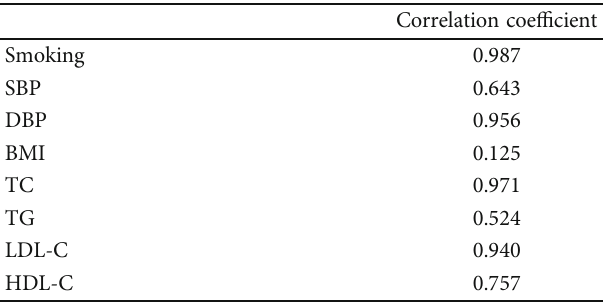
Table 4: Correlation of T2DM and cardiovascular disease risk factors in the